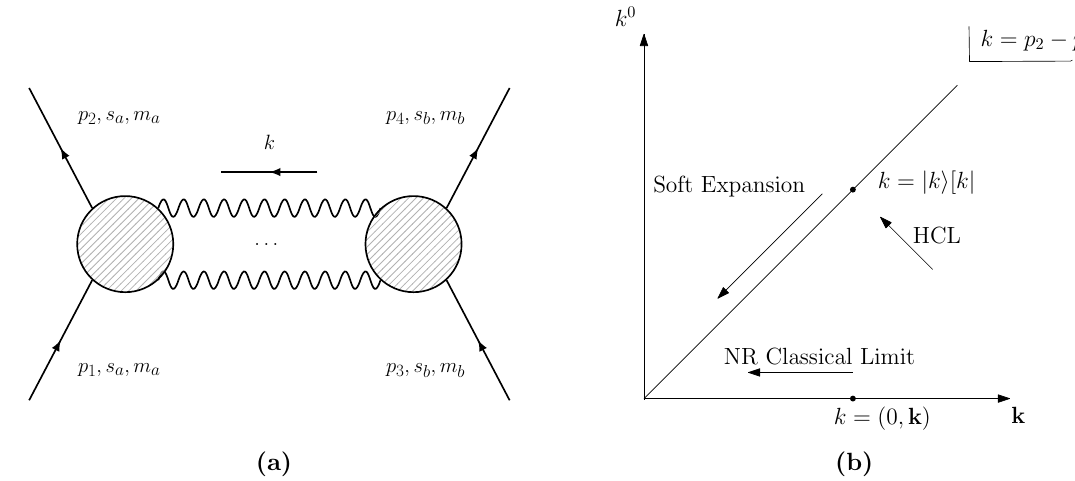
Figure 1. (a) Four-point amplitude involving the exchange of soft gravitons, which leads to classical observables. The external massive states are interpreted as two black-hole sources. (b) Comparison between the HCL and the non-relativistic limit in the COM frame [27, 28, 30]. Spin e(cid:11)ects require subleading orders in the nonrelativistic (NR) classical limit, but can be fully determined at the leading order in HCL through the soft